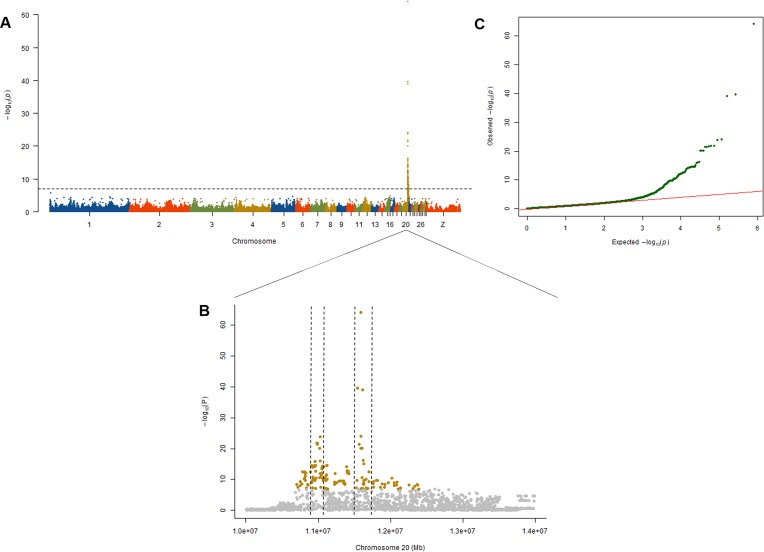
Results from the genome-wide association study (GWAS) of comb color phenotype. (A) Manhattan plot of the GWAS for the comb color phenotype; the y axis shows −log10 P values adjusted by Bonferroni approach for the association tests, and the dashed horizontal line indicates the genome-wide significant threshold value (1.23E-7). (B) A scatter plot presenting all the single-nucleotide polymorphisms (SNPs) tested on chromosome 20 for the comb color phenotype. The extremely significant SNPs in the two peaks are in the two duplications related to fibromelanosis (FM). Among these SNPs, 25 are located in duplication 1, and 23 are located in duplication 2. (C) The quantile–quantile plot of the P values, the x-axis shows the expected −log10-transformed P values, and the y-axis shows the observed −log10-transformed P values.